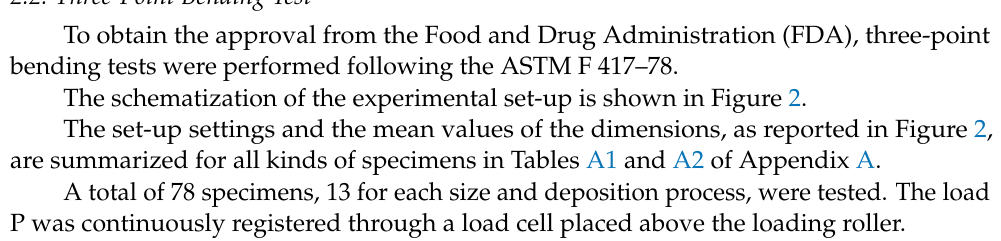
Figure 1. Representation of a typical specimen for: ( a ) three-point bending test; ( b ) nanoindentation test.